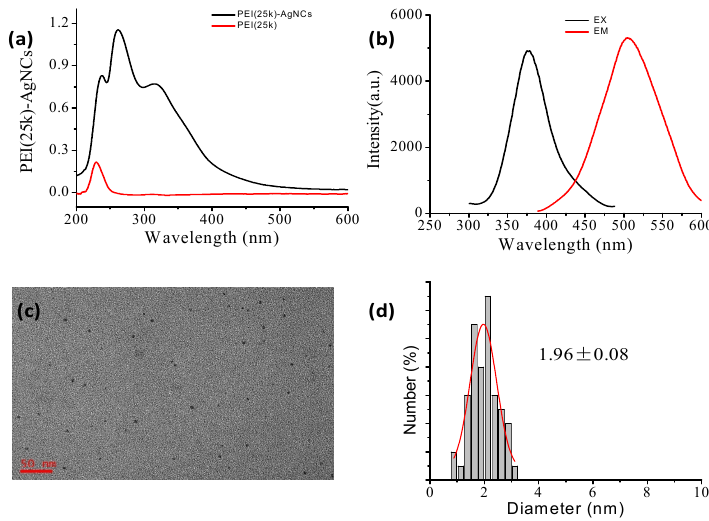
Figure 1. Characterizations of PEI25k-AgNCs. ( a ) The UV-Vis spectra of PEI-AgNCs (dark curve) and PEI (red curve); ( b ) The excitation (dark curve) and emission (red curve) spectra, where EX/EM represents the excitation/emission wavelength; ( c ) Their HRTEM image; ( d ) The corresponding statistic diameter.